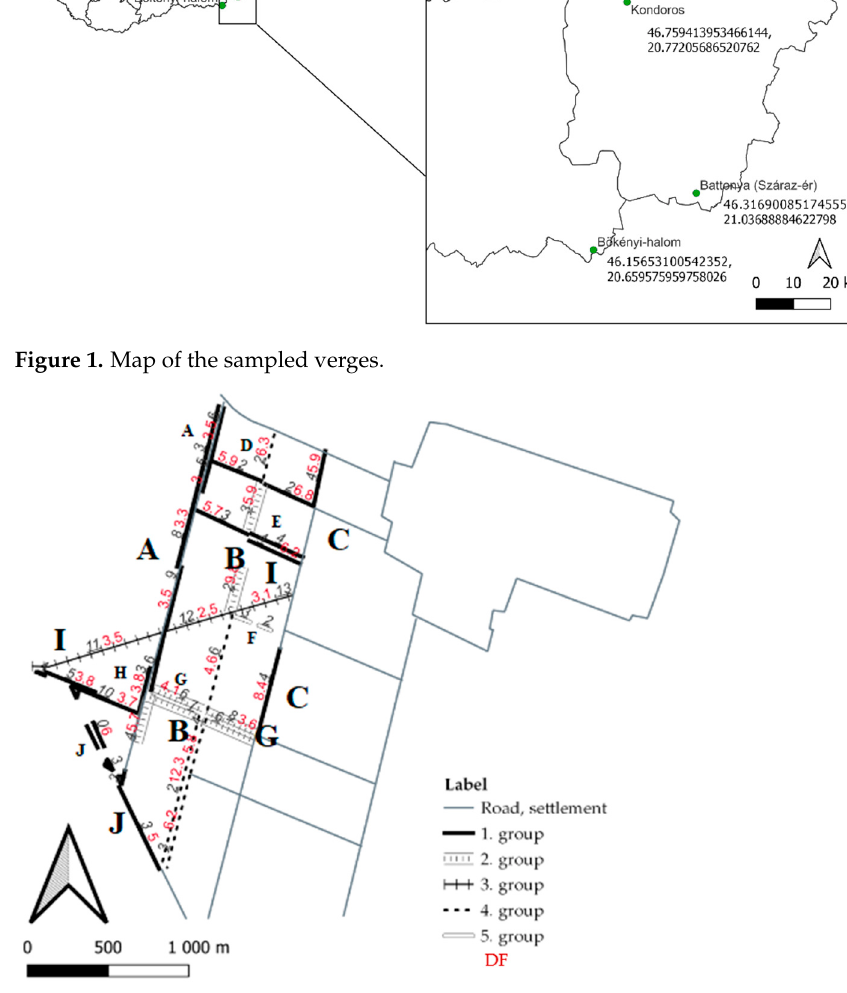
Figure 2. Map of the sampled verges and their code. The age group of sampled verges and the number of their loess species (black numbers), DF: degree of degradation.